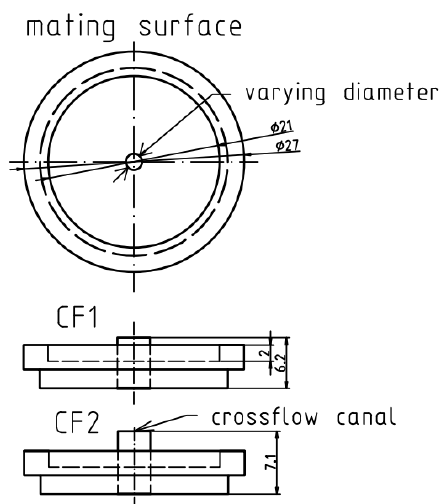
Fig. 4. Exit orifice plate .